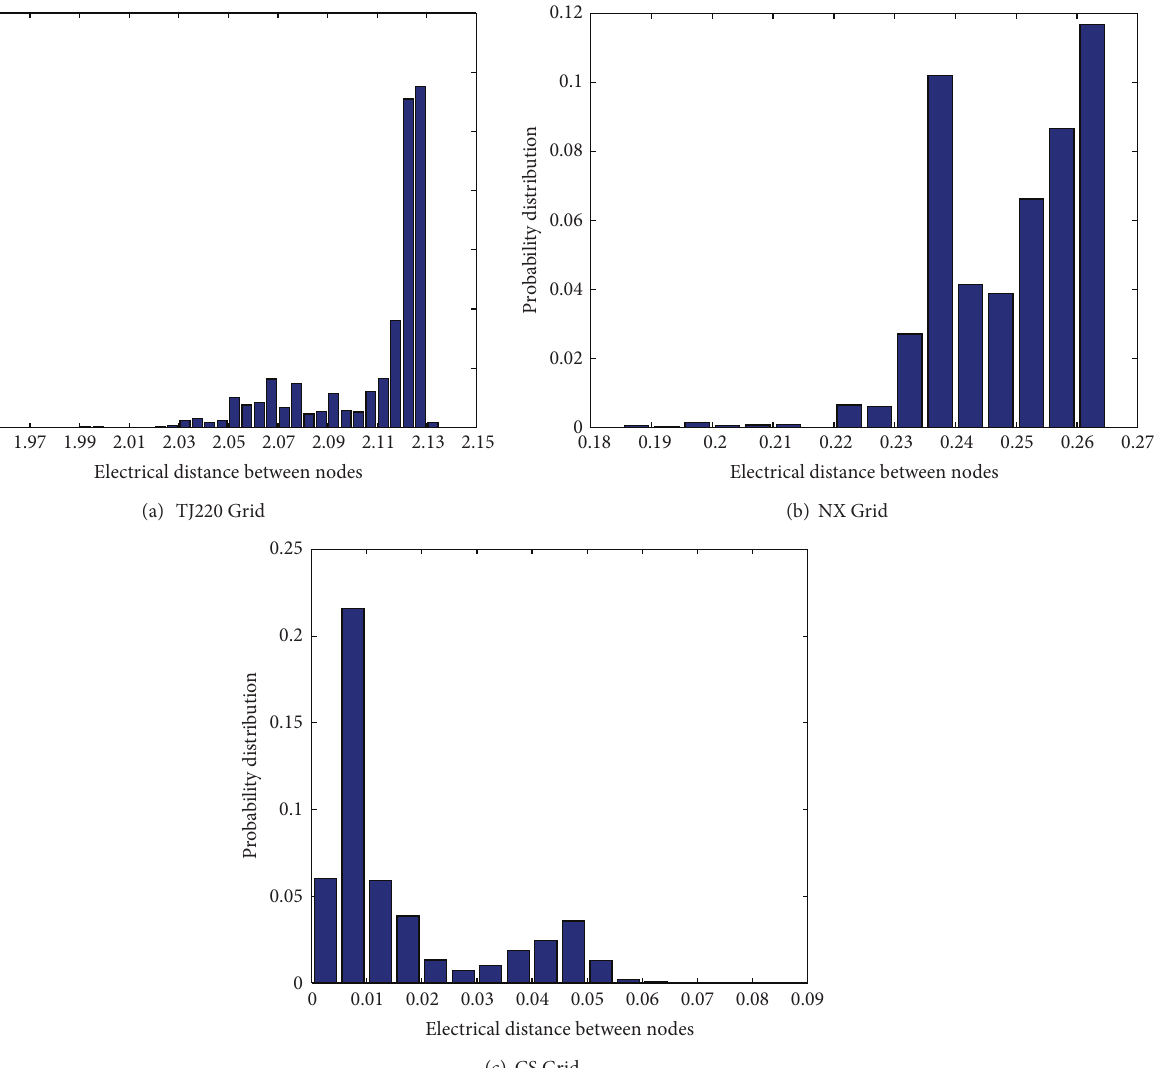
Figure 6: Probability distribution of electrical distance between nodes in power grids.